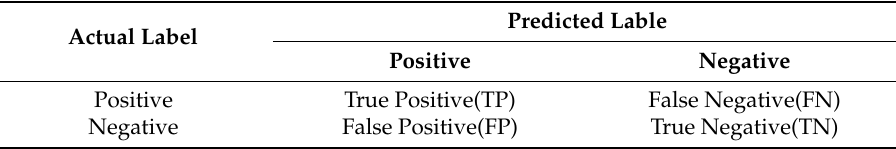
Table 3. Labeling of data according to its predicted label and actual